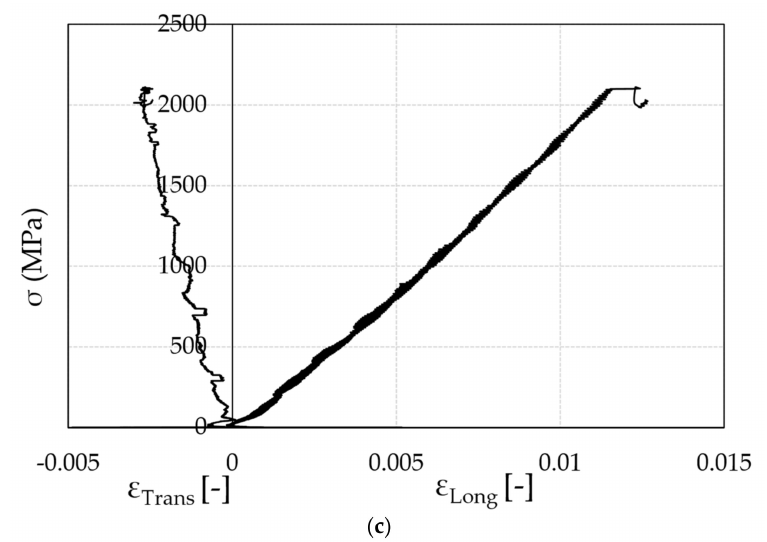
Figure 25. DIC analyses: ( a ) Left: undeformed mesh; Right: deformed mesh relative to a frame close to the cable break; ( b ) SA Specimen_3–Up: longitudinal strain distribution. The reported values have been obtained averaging the strain along the central alignment of the mesh (alignment 2 in Figure 18); ( c ) SA Specimen_3: experimental stress-strain curves (longitudinal –positive– and transversal –negative– strain).